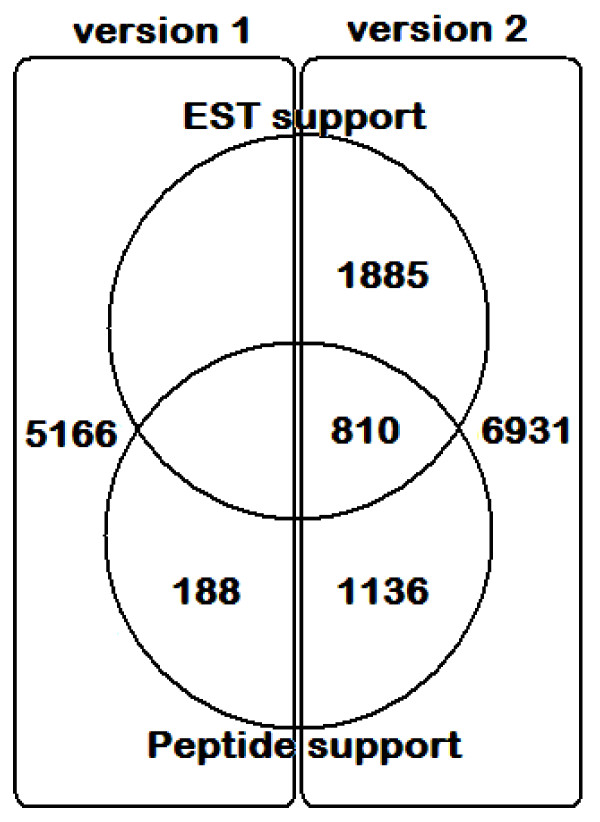
Comparison of S. nodorum annotated gene versions and confirmation by either MASCOT peptide matching or EST alignment. Version 2 genes are derived from EST alignments and a second round of EST-trained gene predictions. Version 2 genes and are considered to be more reliable than the remaining tentative version 1 gene annotations.